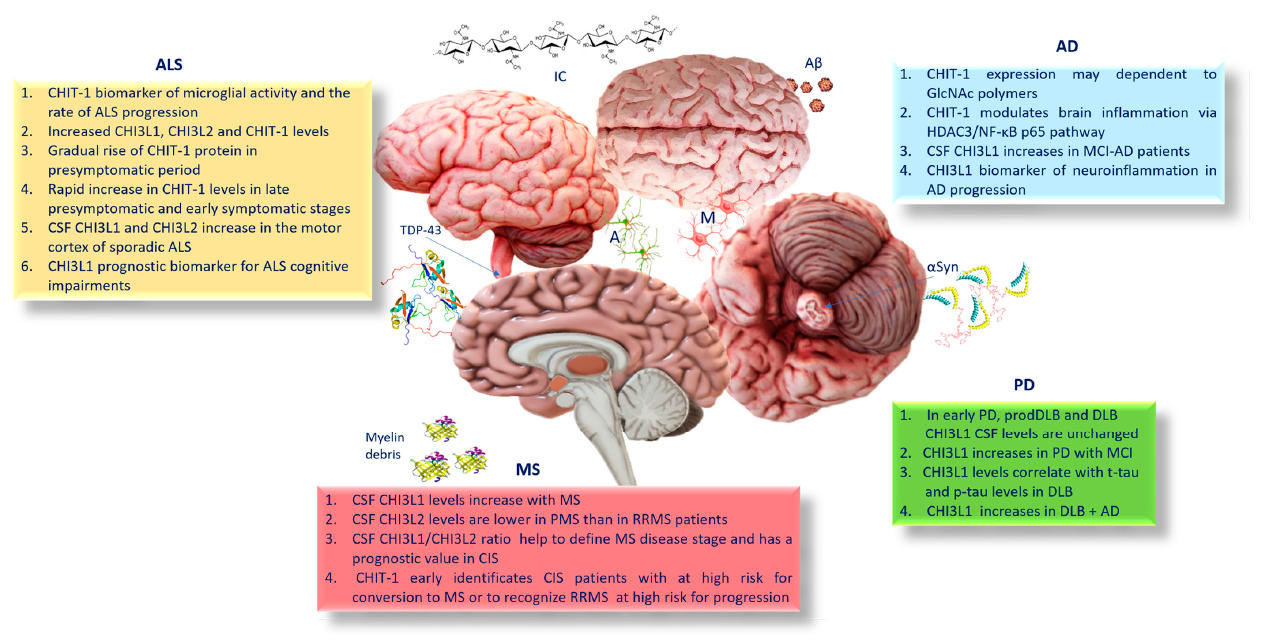
Figure 2. Schematic representation of the chronological profiles of Chitinases in AD, PD, ALS, and progression. Abbreviation = AD: Alzheimer’s disease; PD: Parkinson’s disease; ALS: amyotrophic lateral sclerosis; MS: multiple sclerosis; CSF: cerebrospinal fluid; CHI3L1: chitinase-3-like protein 1; CHI3L2: chitinase-3-like 2; MCI: mild cognitive impairment; CIS: clinically isolated syndrome; DLB: dementia with Lewy bodies; prodDLB: prodromal dementia with Lewy bodies.